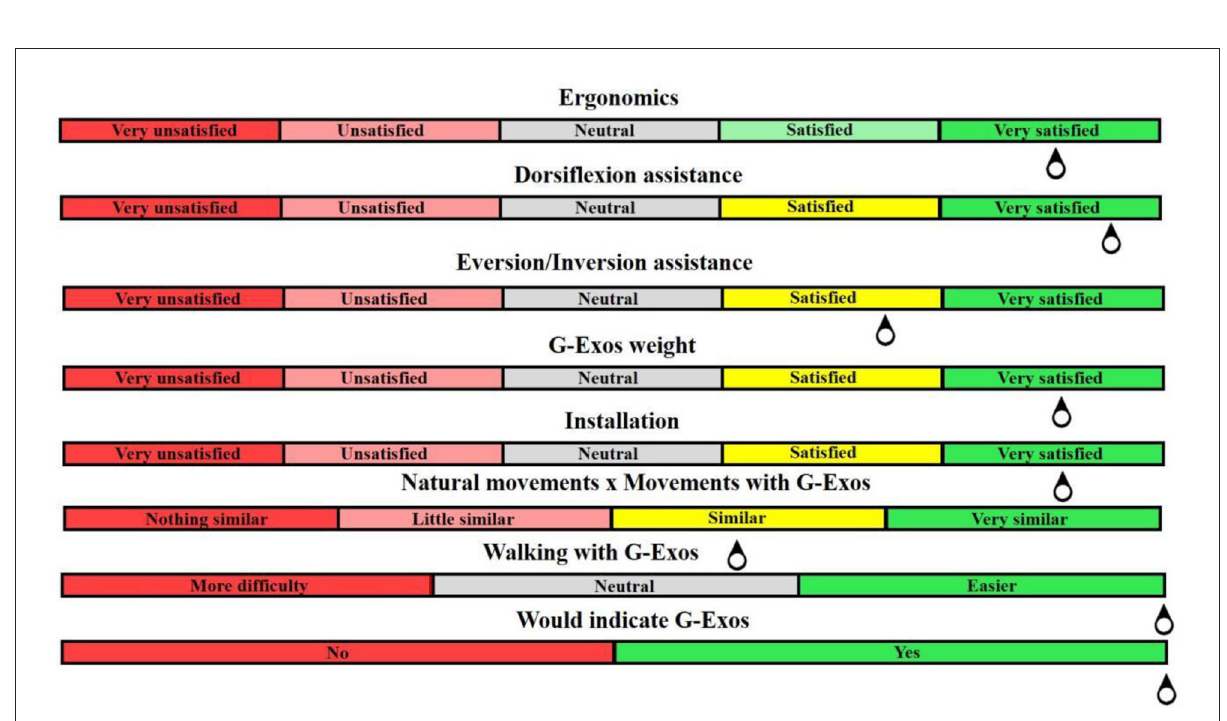
FIGURE9 Summary of the results obtained from the questionnaires applied to the functionality of